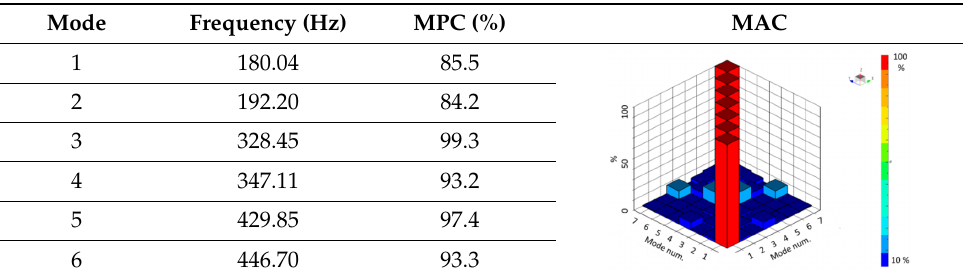
Table 8. Natural frequency result and mode similarity evaluation through modal test.